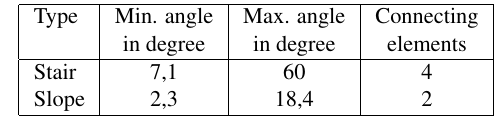
Table 1. Thresholds for the trajectory analysis